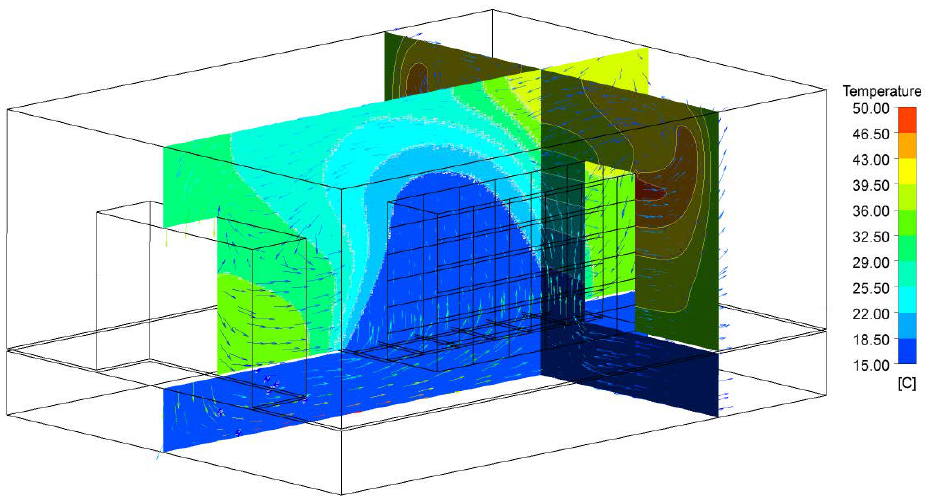
Figure 3. Data center layout used in our